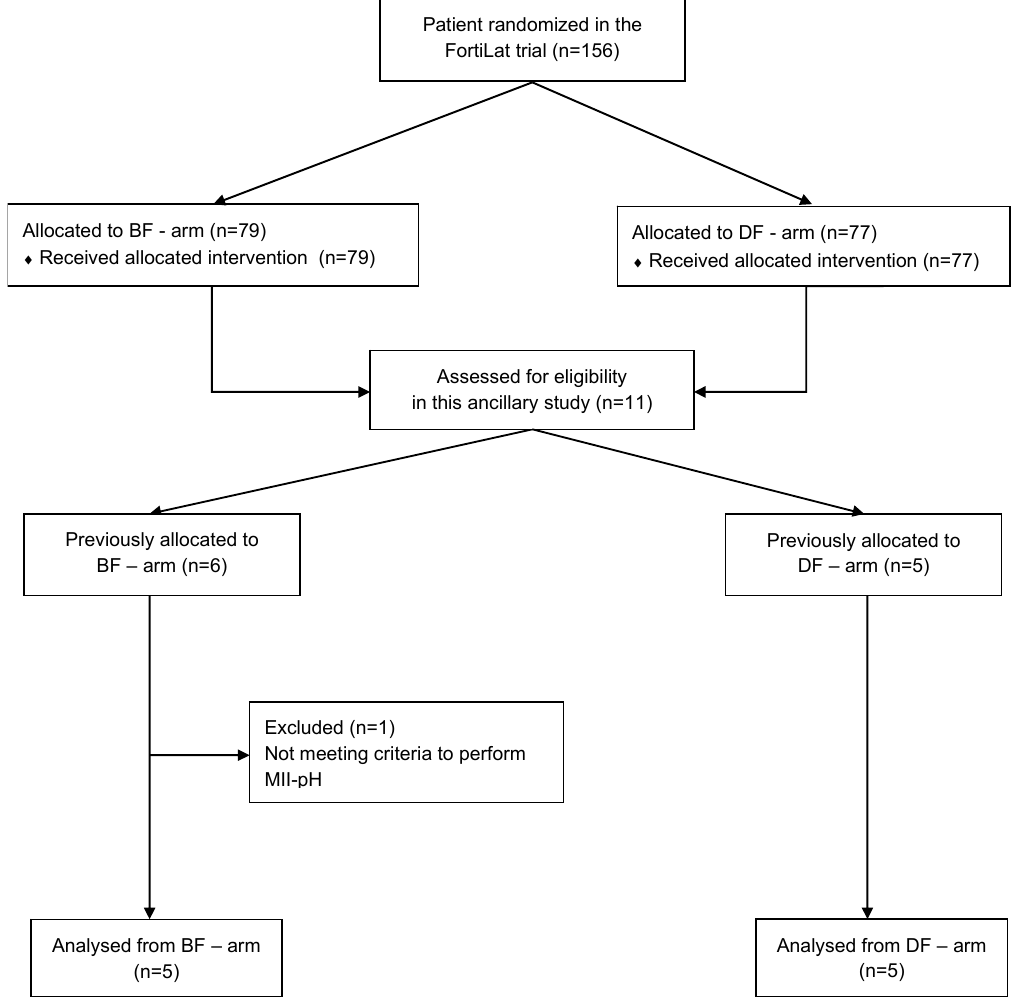
Figure 1. Diagram of patient allocation. BF arm: arm treated with bovine milk-derived human milk fortifier; DF arm: arm treated with donkey milk-derived human milk fortifier; MII-pH: multichannel intraluminal impedance and pH monitoring.